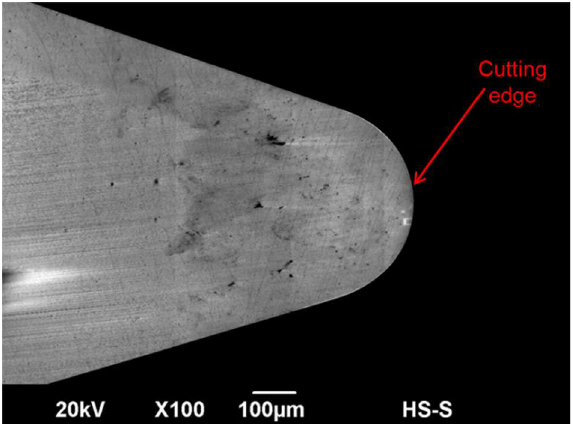
Figure 7. Scanning electron microscope (SEM) image of binderless cubic boron nitride (cBN) cutting tool.